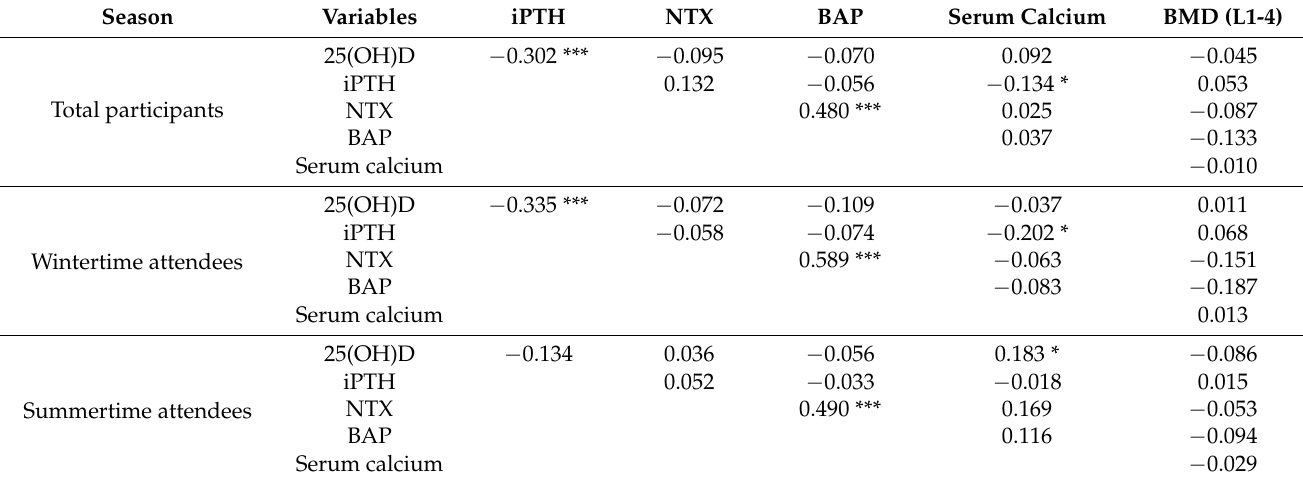
Table 4. Correlation between serum 25(OH)D levels and bone turnover marker